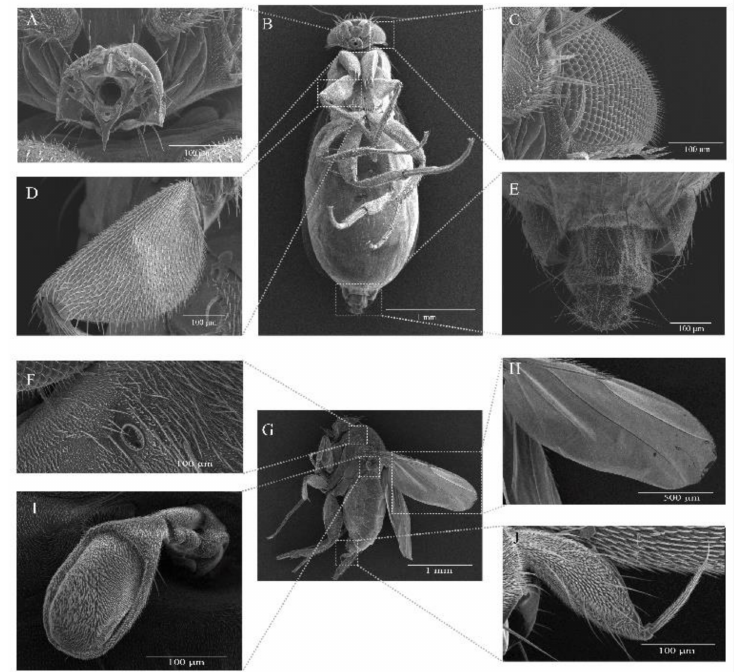
Figure 3. Scanning electron micrograph of the parasitic flies M. scalaris from Chongqing (female: ( A – E ), male: ( F – J )). Female: ( A ) mouthpart, ( B ) segmental venter of female, ( C ) compound eyes, ( D ) tibia, and ( E ) female terminalia. Male: ( F ) spiracle, ( G ) left face of male, ( H ) wing, ( I ) haltere, and ( J ) male